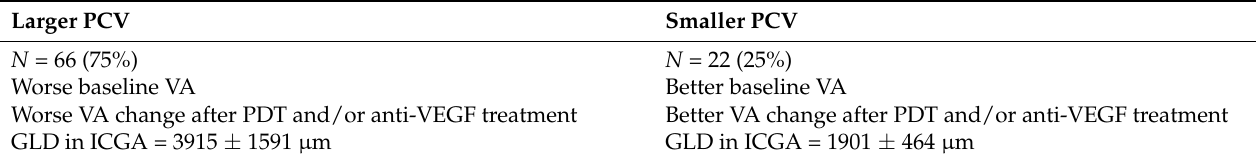
Table 3. Characteristics of larger PCV and smaller PCV.